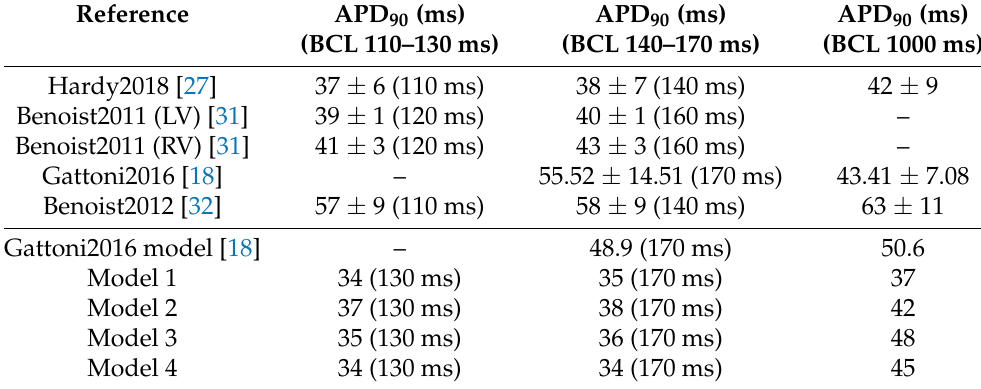
Figure 5. APD and conduction velocity (CV) restitution curves in four selected models. Left panel: APD restitution curve measured in experiments on single cells using microelectrode techniques (Hardy et al. 2018 [27]) combined with simulation results from the updated Gattoni2016 cellular models. Central (Model 1) and right (Model 2) panels: APD restitution curves (top row) in 1D tissue models of myocardial tissue strip in comparison with 0D cellular models and CV restitution curves in 1D models (bottom row). Table 2. Comparison of APD at different BCLs in experimental data, the original Gattoni2016 cellular model and our updated